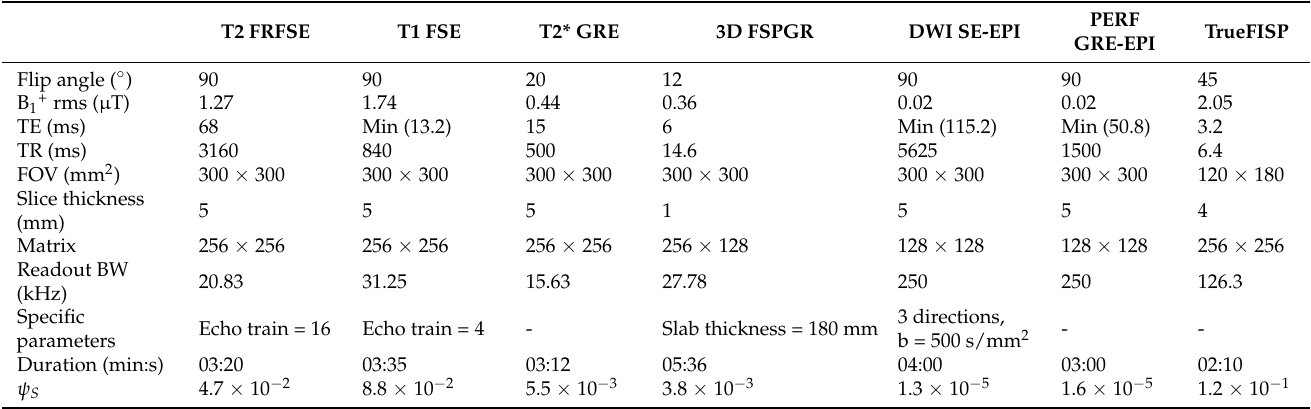
Table 1. Parameters relevant to the analysed MRI pulse sequences.